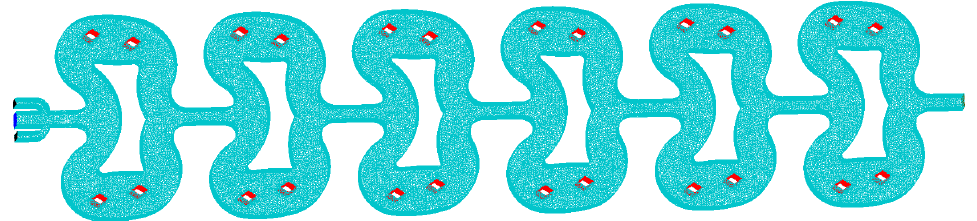
Figure 1. 3D mesh of the microreactor composed of 4,278,327 elements. A homogeneous simulation used water and ethanol as the flow phase, both of which used the same volumetric flow rates. The total flow rate ranged from 10–40 mL/min with an interval of 10 mL/min. The pressure–velocity coupling scheme was resolved by